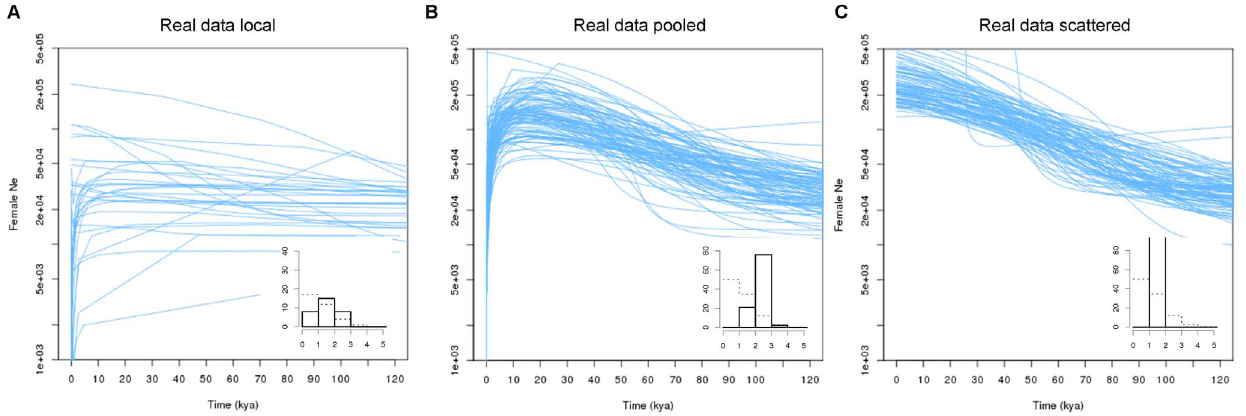
Figure 4. Three different sampling strategies for real data from the buffalo. Local , pooled and scattered sampling of real D-loop data from 34 African buffalo populations. The replication of each sampling strategy involved random drawing of the appropriate number of samples from demes as explained in the main text.